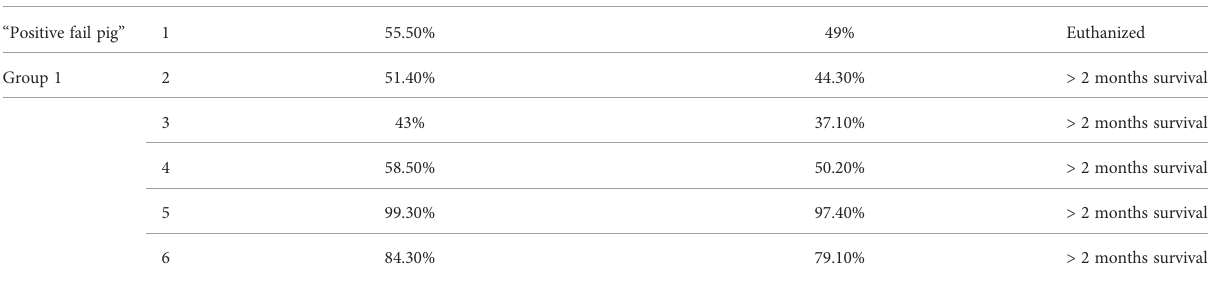
TABLE 4 Tumor volume coverage for all the pigs treated with 166Ho for two typical values of absorbed dose, 60 and 100 Gy. Groups